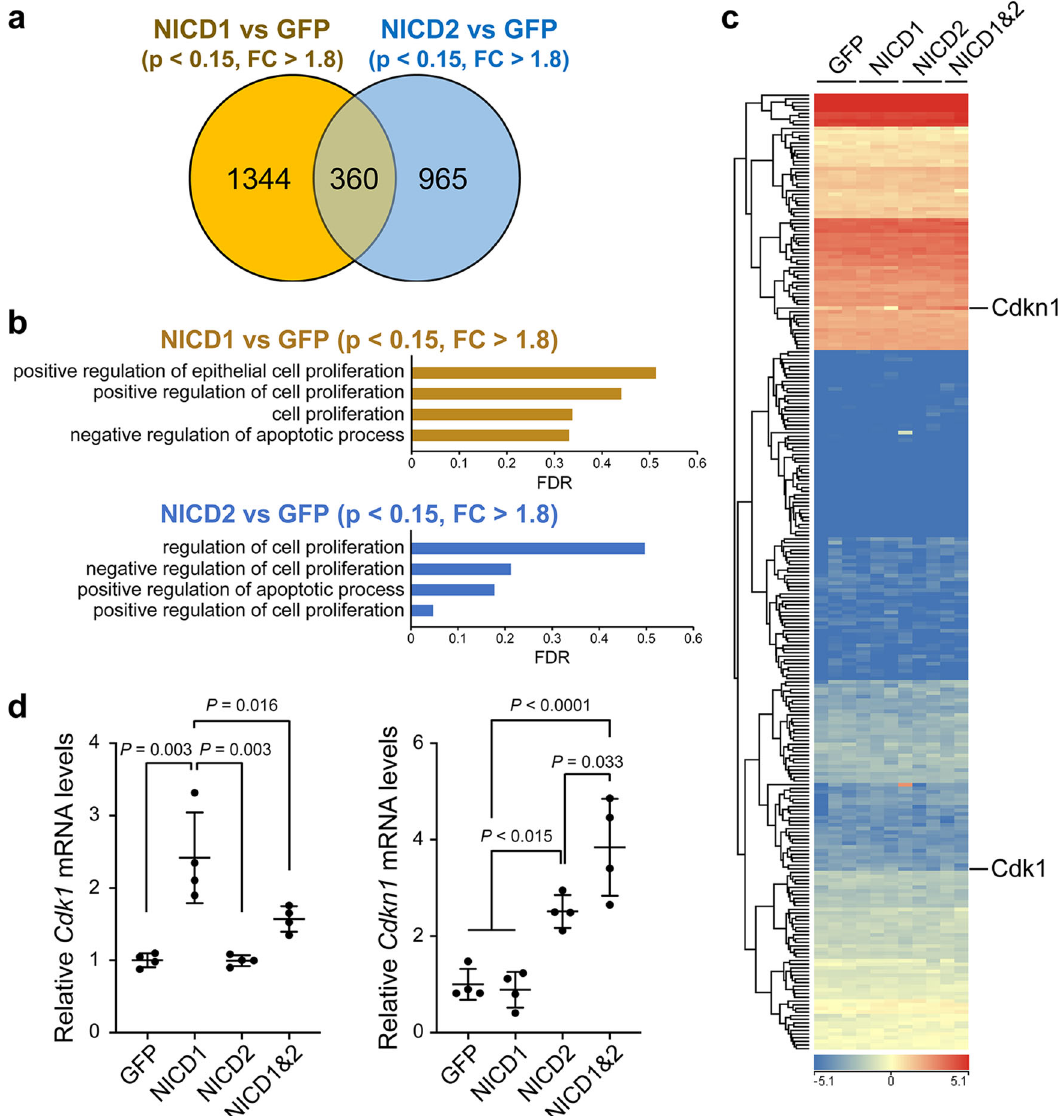
Fig. 6 Comprehensive gene expression analysis in liver tissues following forced activation of the Notch1 and Notch2 signaling. C57Bl6/J male mice were intraperitoneally injected with adeno-associated virus 8 (AAV8) expressing the control green fl uorescent protein (GFP) (6 × 10 11 viral genomes (vg) per mouse), NICD1 and GFP (3 × 10 11 vg each per mouse), NICD2 and GFP (3 × 10 11 vg each per mouse), or NICD1 and NICD2 (3 × 10 11 vg each per mouse). Five days later, total RNA was isolated from the excised liver tissues and subjected to expression microarray analysis ( a – c ) and quantitative RT-PCR ( d ). The Venn diagram ( a ) and enriched Gene Ontology (GO) terms ( b ) indicate the changes in the gene expression pro fi les following the overexpression of NICD1 or NICD2 compared to the overexpression of the control GFP. The differentially expressed genes were de fi ned by P < 0.15 and a fold change (FC) >1.8 ( n = 3 in each group). c Heatmap illustrating the expression levels of the cell proliferation-related genes annotated in GO analysis, ‘ G2/M transition of mitotic cell cycle ’ (GO:0000086) in the liver ( n = 3 in GFP, NICD1, and NICD2 groups; n = 2 in NICD1&2 group). d Quantitative RT-PCR analysis of the selected candidate genes. The values represent the mean ± SD from four mice in each group and are expressed relative to those in the control GFP group (set as